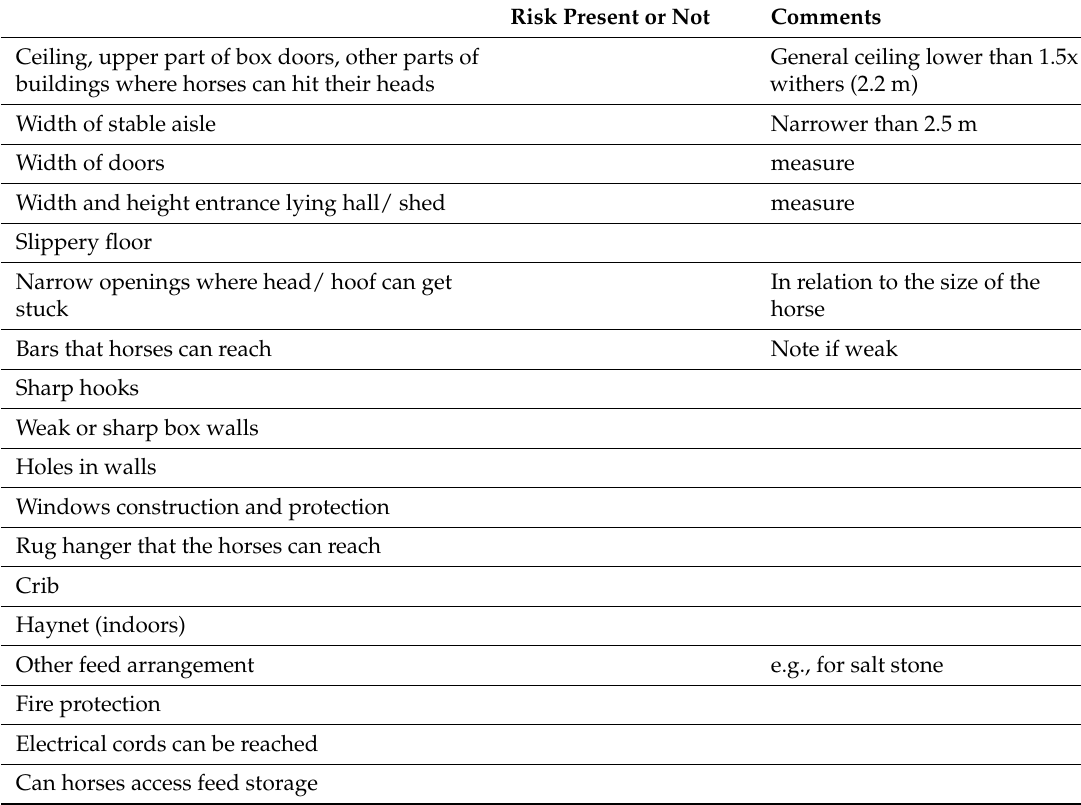
Table A2. Check list – Risks of injury. Walk systematically through all parts of the RS where the horses spend time. All risks are